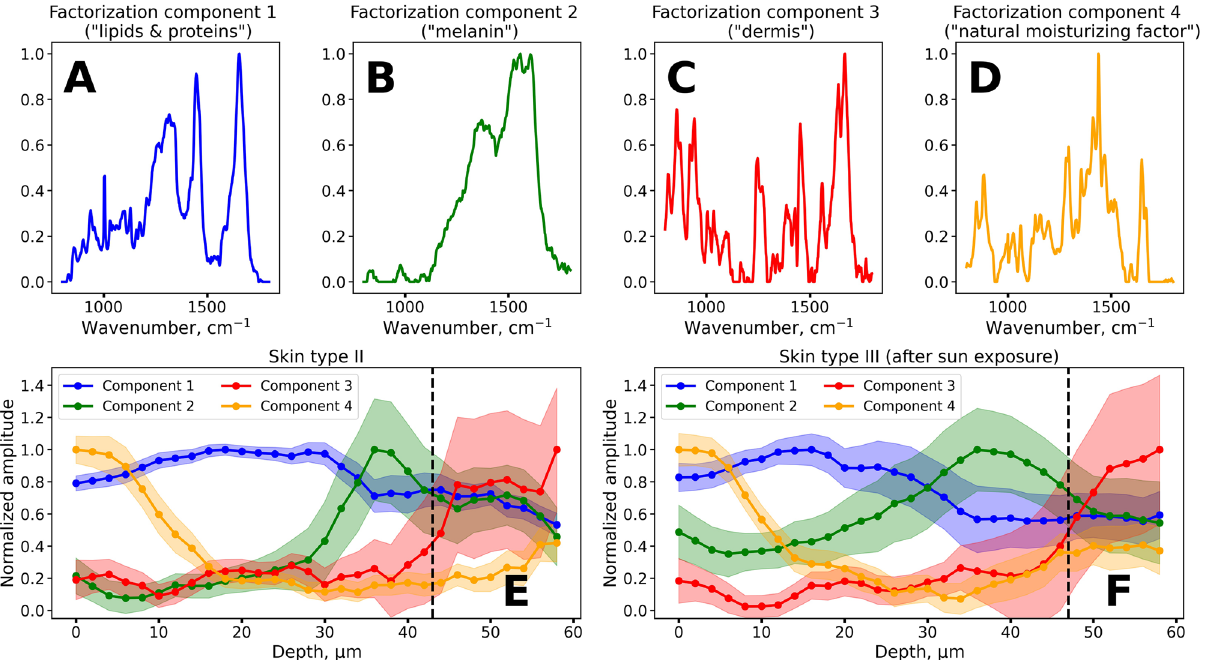
Figure 4. The results of the non-negative matrix factorization procedure applied to the Raman spectra of the skin. ( A – D ) Output spectral components, obtained from the factorization procedure. ( E , F ) Typical depth profiles of the amplitudes of decomposition components for the volunteers with skin type II (E) and skin type III after sunlight exposure ( F ). Vertical dashed line in ( E , F ) indicates the position of the dermal–epidermal junction. The spectral components and amplitude profiles are normalized by their maximum value for